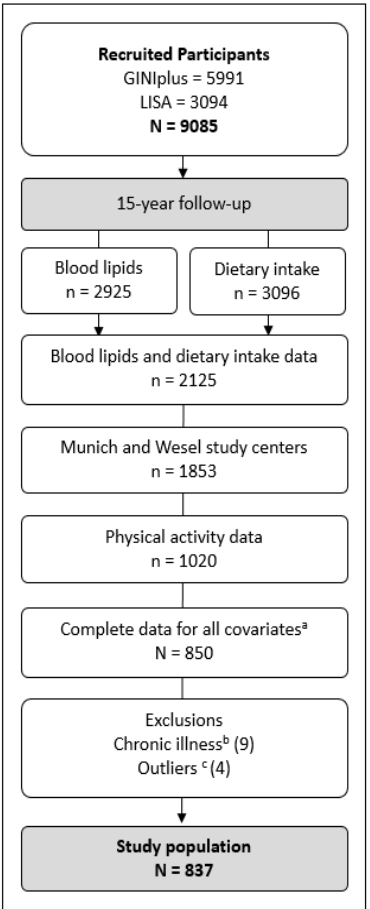
Figure 1. a Covariates: Total energy intake, BMI, pubertal stage, fasting status, parental education, study (arm), region, age, sex (for stratified analyses). b Chronic illness: Diabetes ( N = 3), celiac disease ( N = 3), cancer ( N = 2), Crohn’s disease ( N = 1). c Outliers: Outliers in n-3 PUFA intake ( N = 1), in n-6 PUFA intake ( N = 2) and in MVPA ( N = 2), visually identified using descriptive plots. Table 1. Study population characteristics.